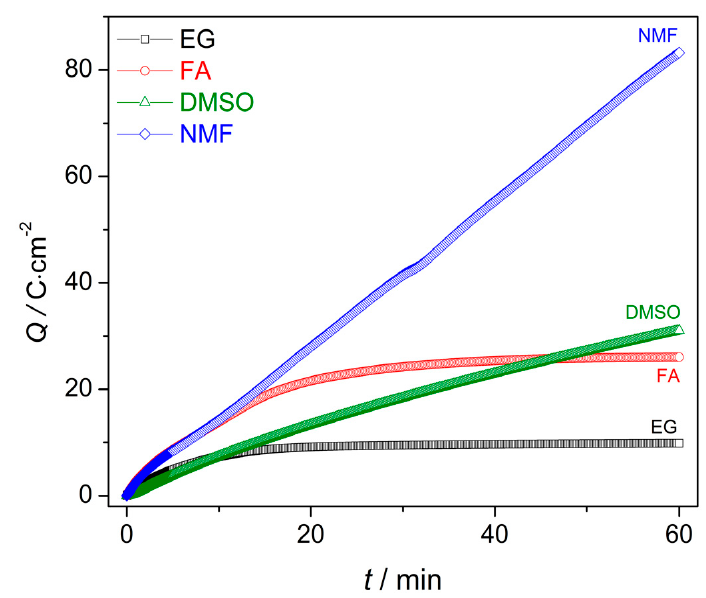
Figure 4. Charge curves during the first hour of anodization for the EG, FA, NMF and DMSO samples.